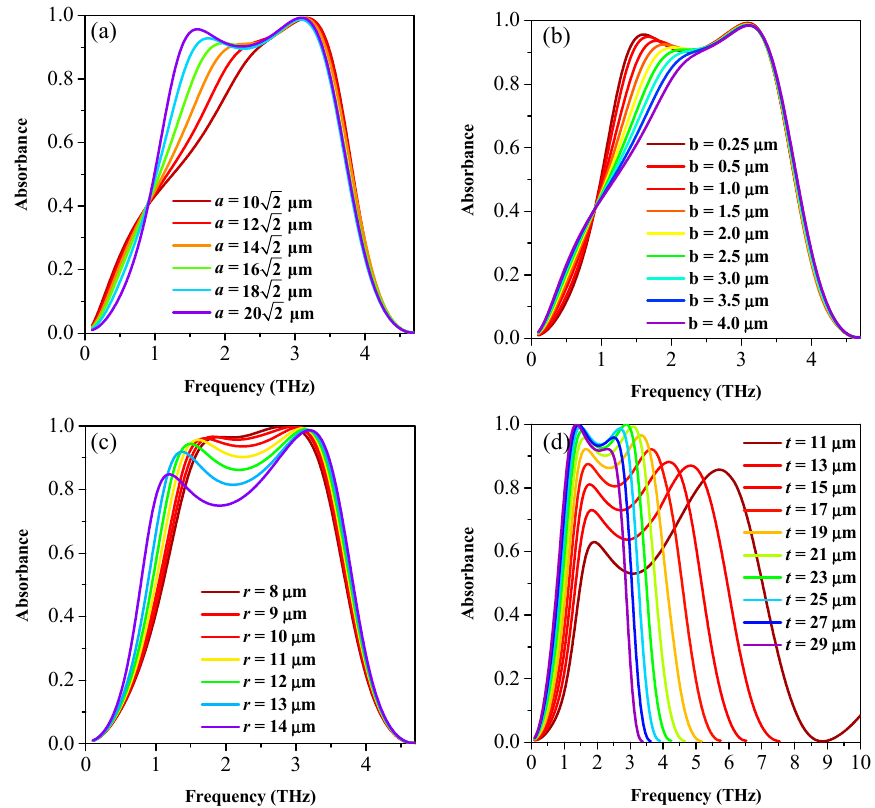
Figure 5. The absorption spectra as a function of the geometric parameters a , b , r , and t are displayed in ( a ), ( b ), ( c ), and ( d ), respectively. Particularly, in ( a ), we reduce the a while increasing b to maintain the √2 a + 2 b = 40 μ m and to keep the electric continuity of the hybrid-patterned graphene; in ( b ), ( c ), and ( d ), only one single parameter b , r , or t is changing while keeping the other parameters fixed.